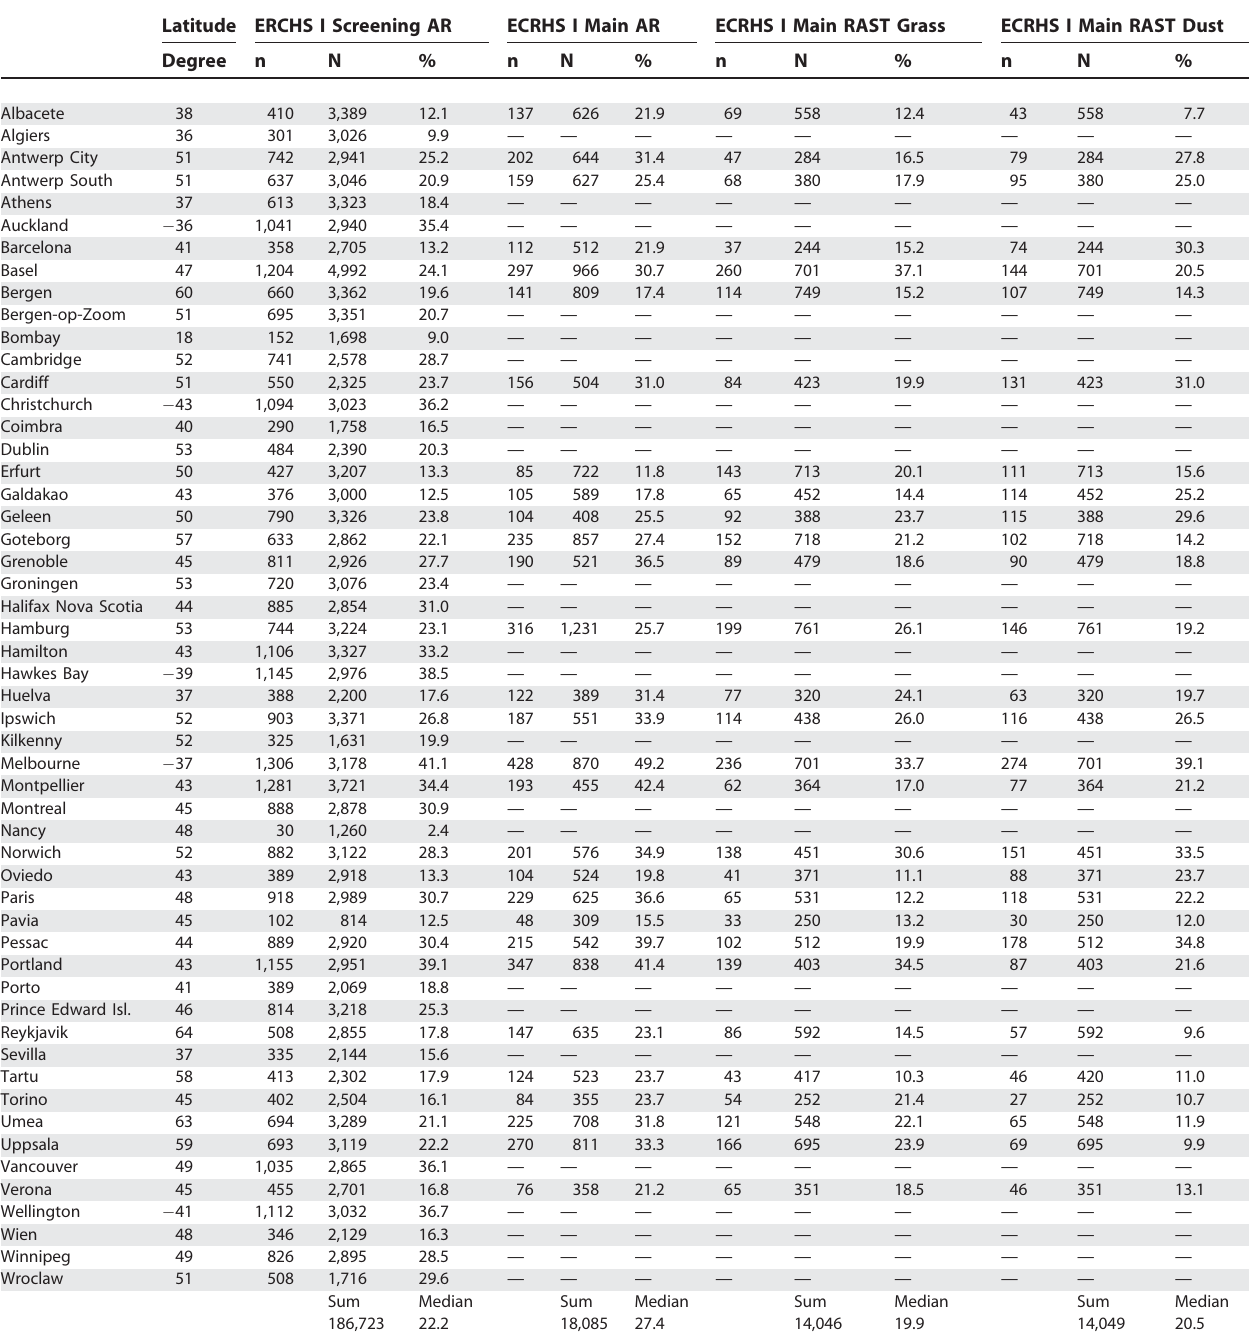
Table 1. Lifetime Prevalence of AR and Prevalence of Positive RAST Values by Centre in ECRHS I Screening Latitude ERCHS I Screening